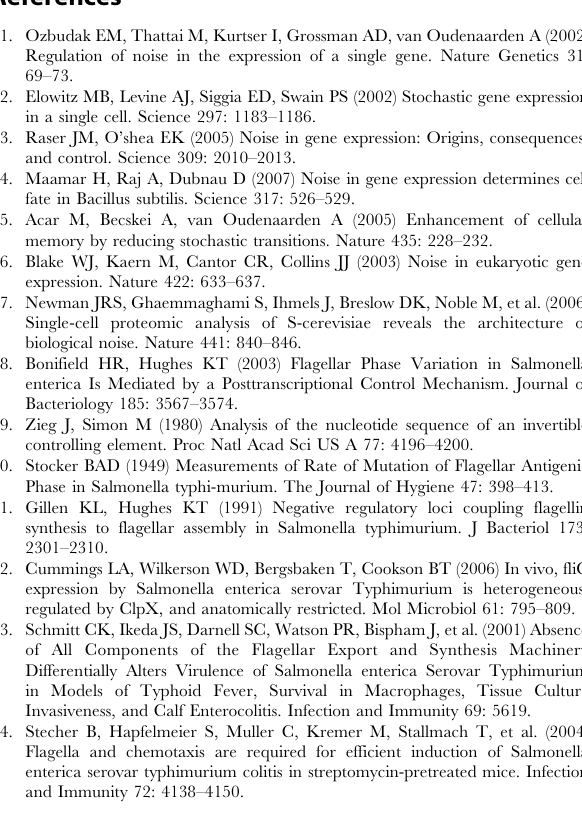
Figure S3 Lineage tree of microcolony growth and expression pattern of the dcm promoter. GFP expression is plotted in grey (light colored boxes represent high levels of GFP, and dark boxes represent low levels), illustrating the temporal pattern of switching of the dcm promoter, isolated from a control population. The image and the lineage tree are based on Movie S2. Table S1 Sequenced inserts from selected and control popula- tions. Sequence data from the 240 clones used for analysis. Found at: doi:10.1371/journal.pgen.1000307.s004 (0.07 MB XLS) Text S1 Supporting information containing supplementary materials and methods as well as supplementary figure legends. Found at: doi:10.1371/journal.pgen.1000307.s005 (0.06